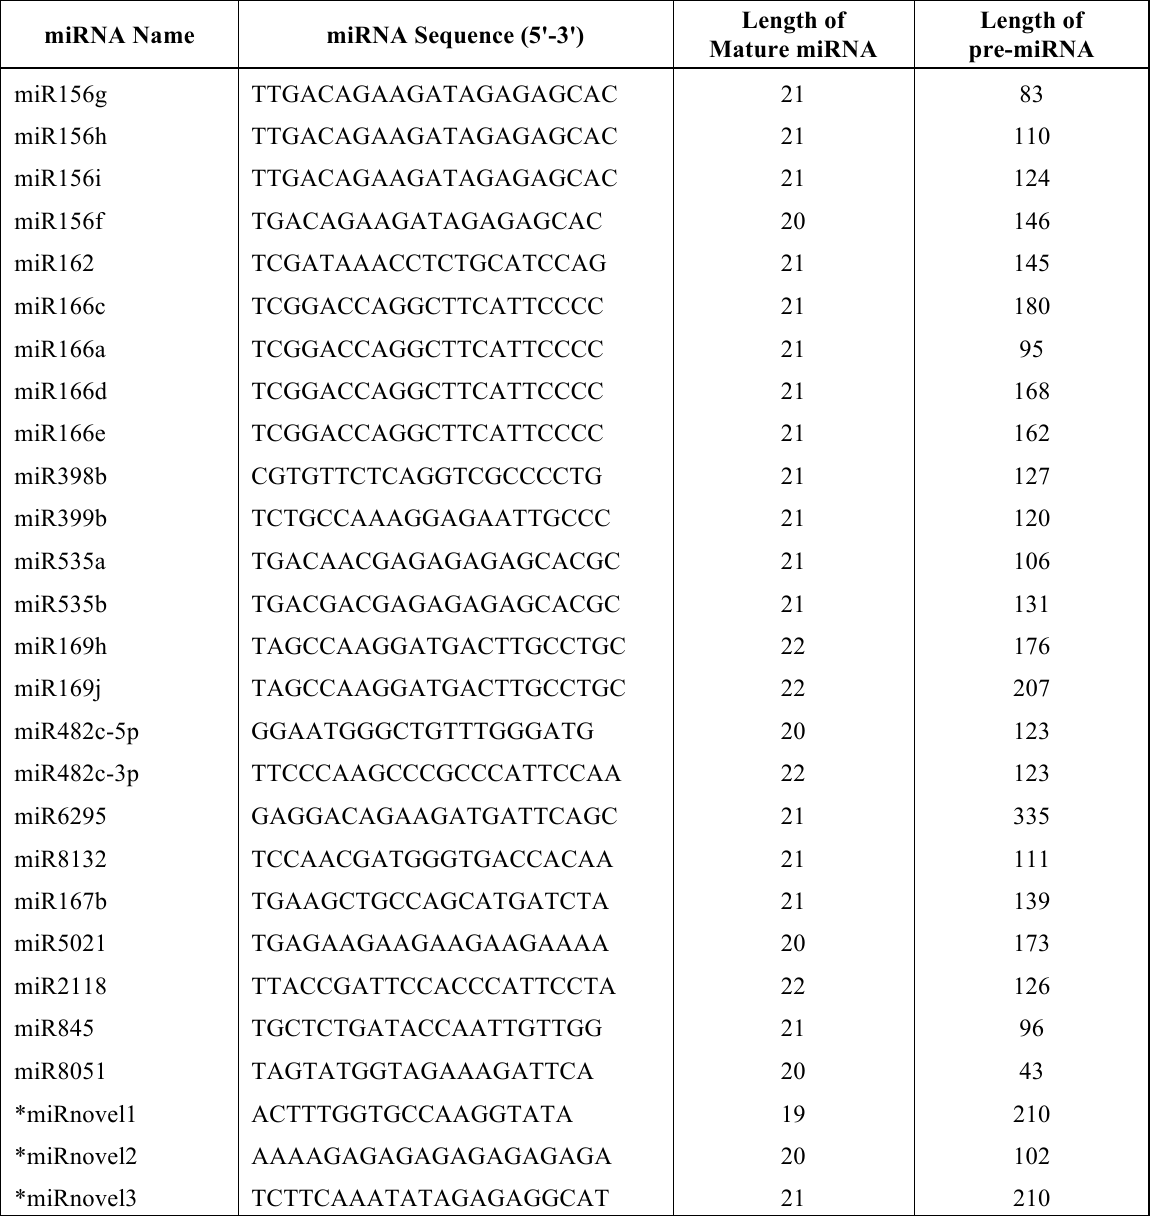
* indicates the novel miRNAs identified in this